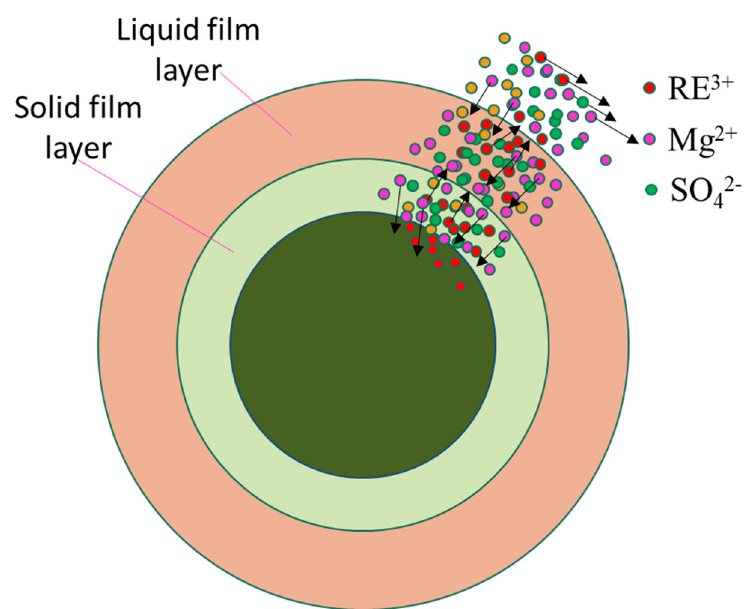
Figure 1. Schematic diagram of the rare earth ion exchange process.